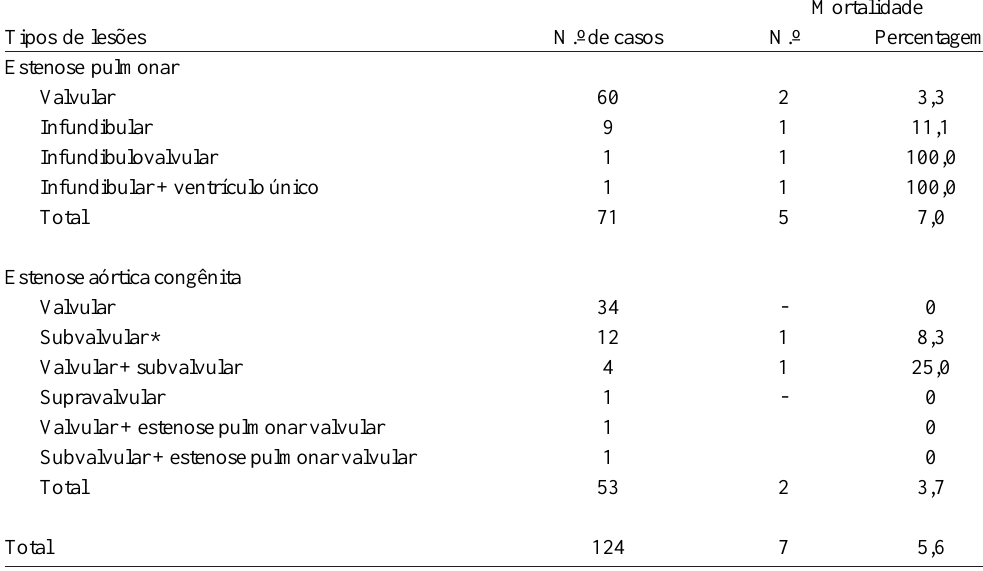
Tabela 2. Cardiopatias congênitas acianóticas com sobregarga de resistência (124 casos)